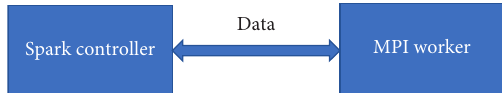
Figure 1: Abstract-level view of the hybrid system.